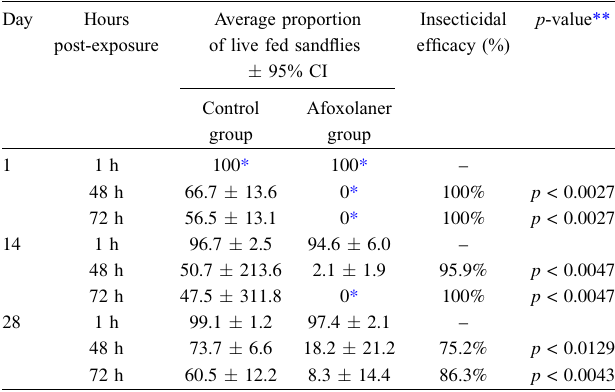
Table 4. Average proportions of live fed sand fl ies and insecticidal ef fi cacy at 1, 48 and 72 h post-exposure.